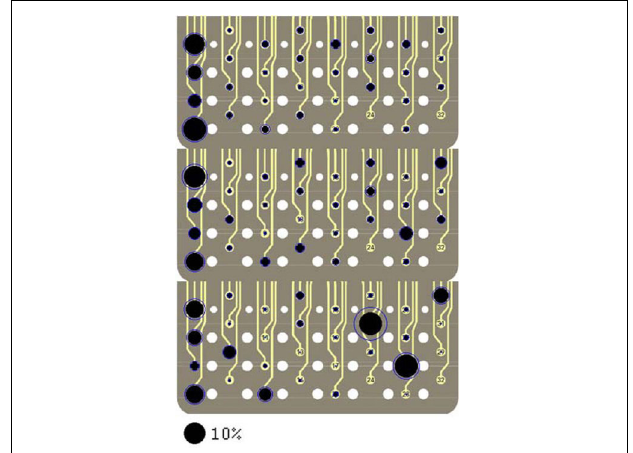
FIGURE 9 | Signal contributions from individual neural channels superimposed on three images of the electrode array in Rat 1. Each image contains percent contributions for one direction of the forelimb force ( X , Y , and Z , top to bottom ). The sizes of the filled, black circles indicate average percent contributions across multiple trials in the session and the rings around the circles show the standard deviations. The large black circle on the bottom represents a contribution of 10%. Contacts 24 and 32 were not